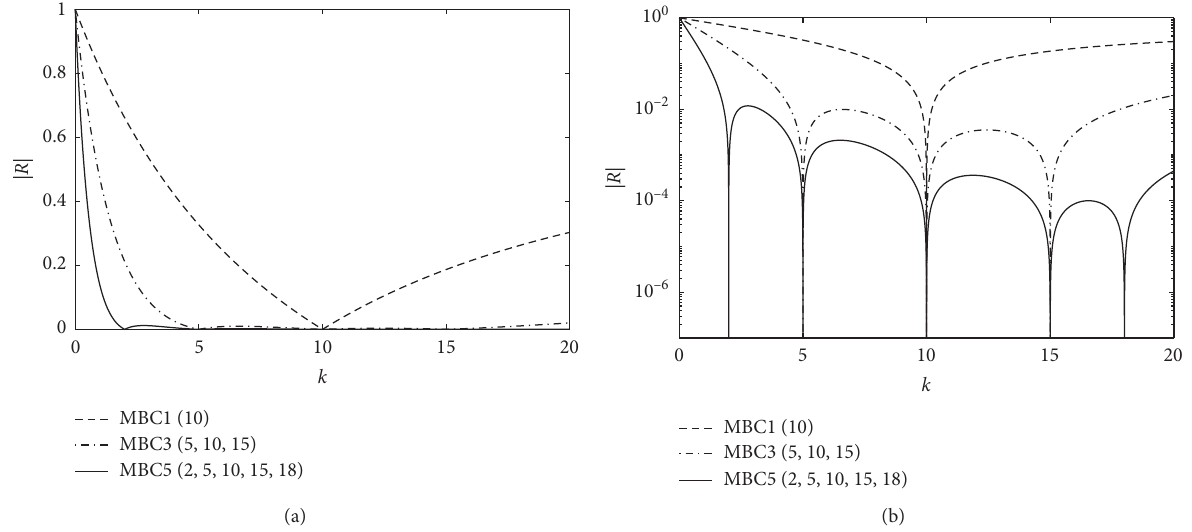
Figure 4: Reflection coefficient modulus for MBCs with multiple wave numbers matched: (a) linear axis for reflection coefficients modulus; (b) logarithmic axis for reflection coefficients